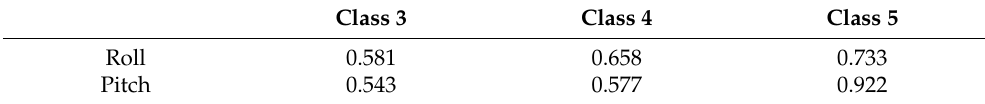
Figure 4. Motion prediction of a ship in class 3–5 sea conditions. ( a ) Class 3 rolling; ( b ) Class 3 pitching; ( c ) Class 4 rolling; ( d ) Class 4 pitching; ( e ) Class 5 rolling; ( f ) Class 5 pitching. Table 1. Error statistics of ship motion prediction in class 3–5 sea conditions (%).